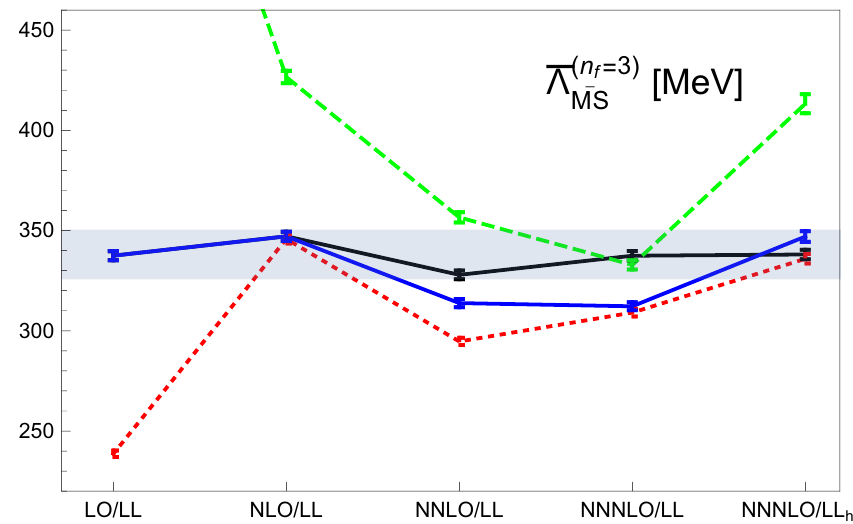
Figure 6 . Determination of (cid:3) ( n f =3) at LL, NLL, NNLL, NNNLL and NNNLL hyp using the data MS set I with ( (cid:23) s ; (cid:23) us ) = (1 =r; C A (cid:11) ( (cid:23) s ) = (2 r )) (continuous black line). We also give the determination of (cid:3) ( n f =3) at LO(LL), NLO(NLL), NNLO, NNNLO and NNNLO hyp using the data set I with MS (cid:23) s = (cid:23) us = 2 =r (dashed green line), (cid:23) s = (cid:23) us = 1 =r (continuous blue line) and (cid:23) s = (cid:23) us = 1 = ( (dotted red line). The error displayed is only the statistical error of the (cid:12)ts. We also show the error band generated by our prediction eq.